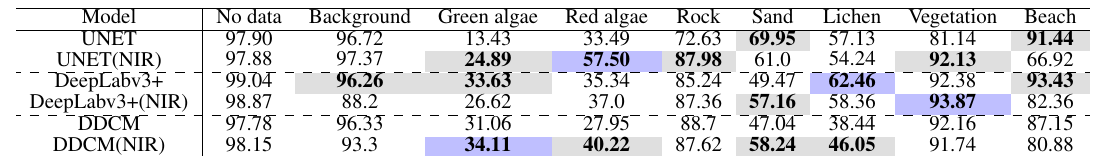
Table 5. Class-wise ACC scores. Noticeable improvement ( > 5%) between the same model type is highlighted in gray. The best score of selected classes is highlighted in blue.